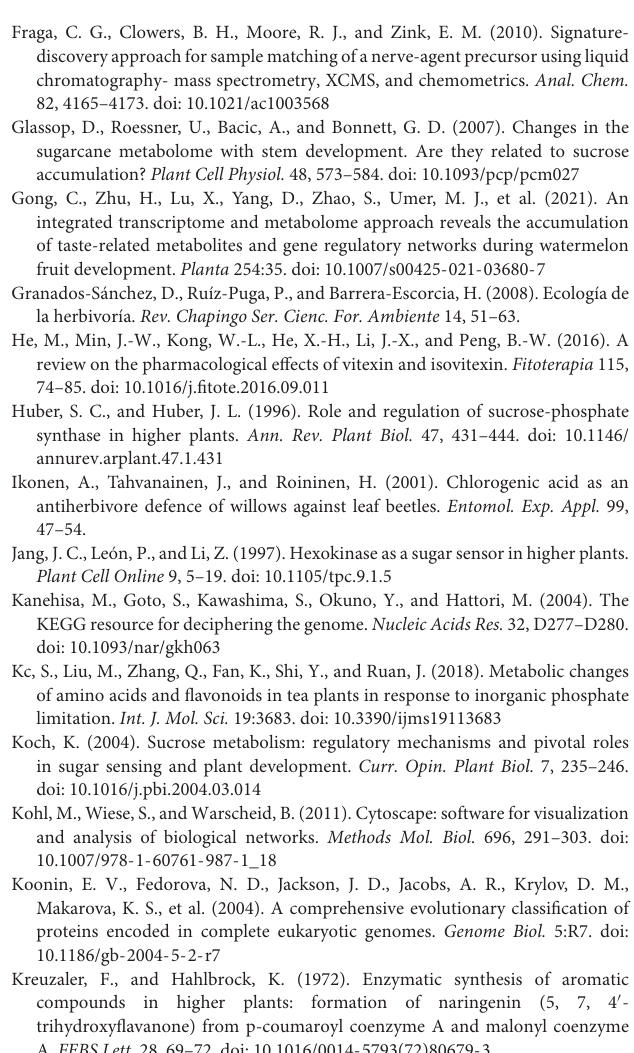
Supplementary Figure 1 | Diagram of the method of testing in tensile strength perpendicular to grain of wood. Supplementary Figure 2 | Total ion chromatograms (TIC) under positive (A) and negative mode (B) . Supplementary Figure 3 | Hierarchical clustering analysis of all metabolites detected in this study. The abscissa indicates three biological replicates of FN41stems (FN41S1, FN41S2, and FN41S3), 165204 stems (165204S1, 165204S2, and 165204S3), FN41 leaves (FN41L1, FN41L2, and FN41L3), and 165204 leaves (165204L1, 165204L2, and 165204L3), and the ordinate indicates the metabolites detected in this study. The red segments indicate a relatively high content of metabolites, while the blue segments indicate a relatively low content of metabolites. Supplementary Figure 4 | Heat map depicting correlation between biological replicate. Supplementary Figure 5 | Co-expression analysis of genes and metabolites in starch and sucrose metabolism pathway. Nodes represent genes or metabolites, and edges represent relationships between any two genes. Edges with solid and dashed lines represent positive and negative correlations, respectively, as determined by a Pearson correlation coefficient > 0.8 or < –0.8,